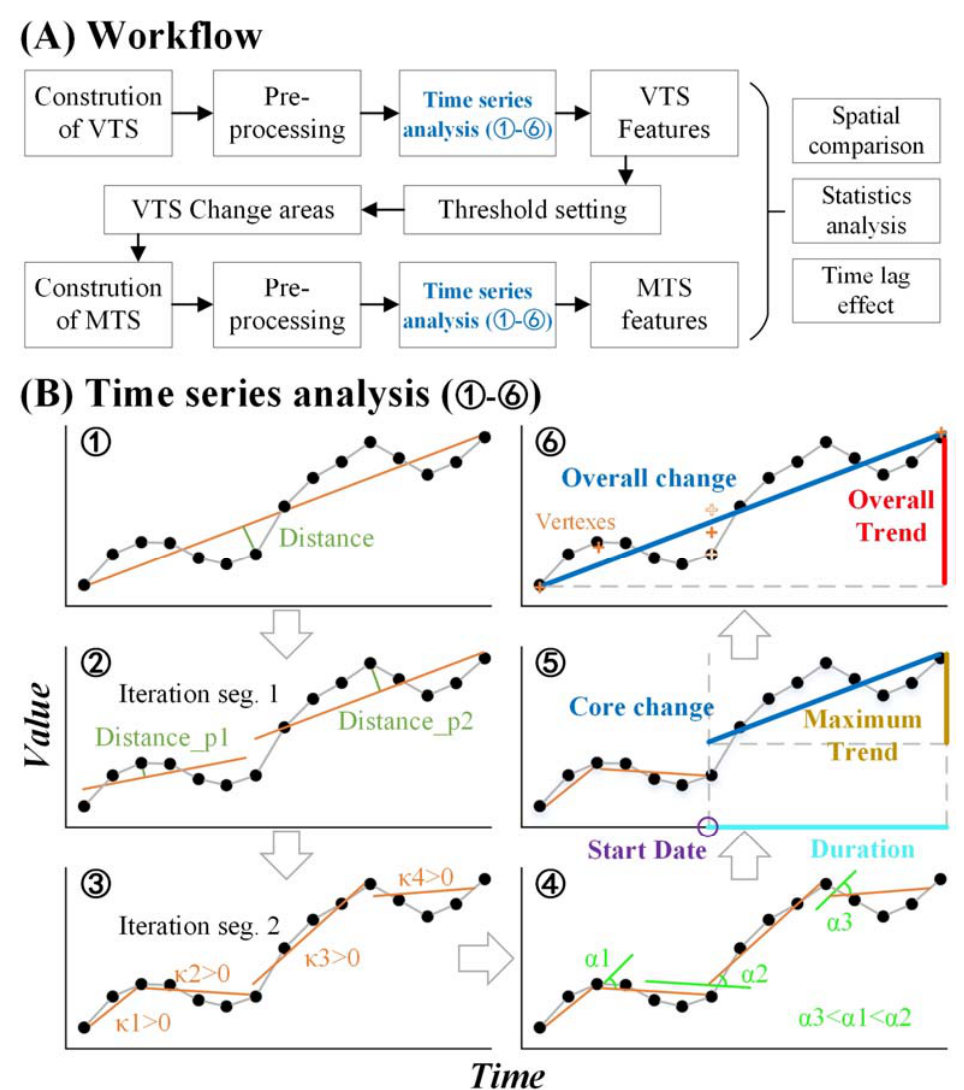
Figure 2. The workflow of this study ( A ), and the sketch map ( B ) for a VIIRS/DNB time series (VTS) and MODIS/NDVI time series (MTS) analysis, including temporal segmentation (B1–B3), iteration number of 2 as an example) and incorporation (B4—B6). Where “distance_” is the perpendicular distance between each data point and fitted line, “ κ ” is the slope of the fitted line, and “ α ” is the included angle between two adjoining fitted lines. The outputs of time series analysis contain four main features, including overall trend, maximum trend, start month, and duration.